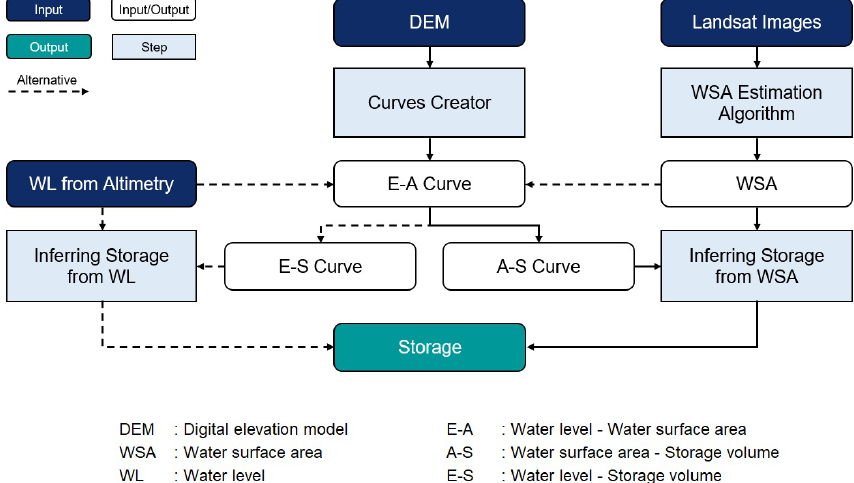
Figure 3. Flowchart representing our methodological approach. The two key steps are the calculation of the E – A , E – S , and A – S curves (from the DEM) and the estimation of the WSA (from Landsat imagery). With this information at hand, we estimate the storage time series of each reservoir. The altimetry water level data are coupled with the E – S curve to re-estimate the storage time series with independent data, thereby validating the estimation based on Landsat